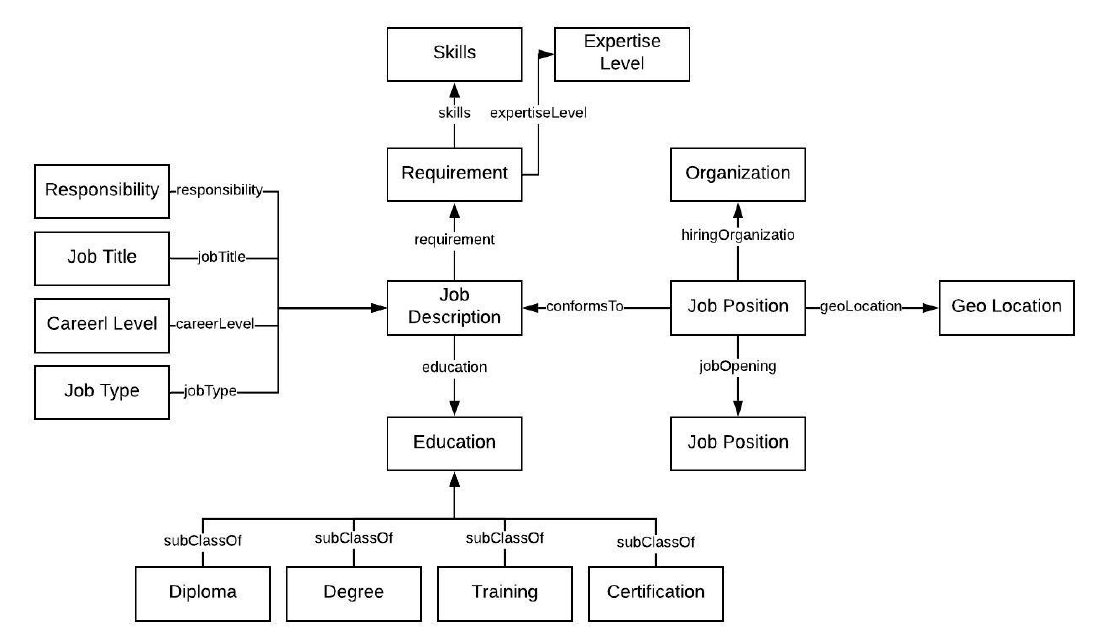
Figure 5. The proposed job description ontology with classes and properties used in SAJ.